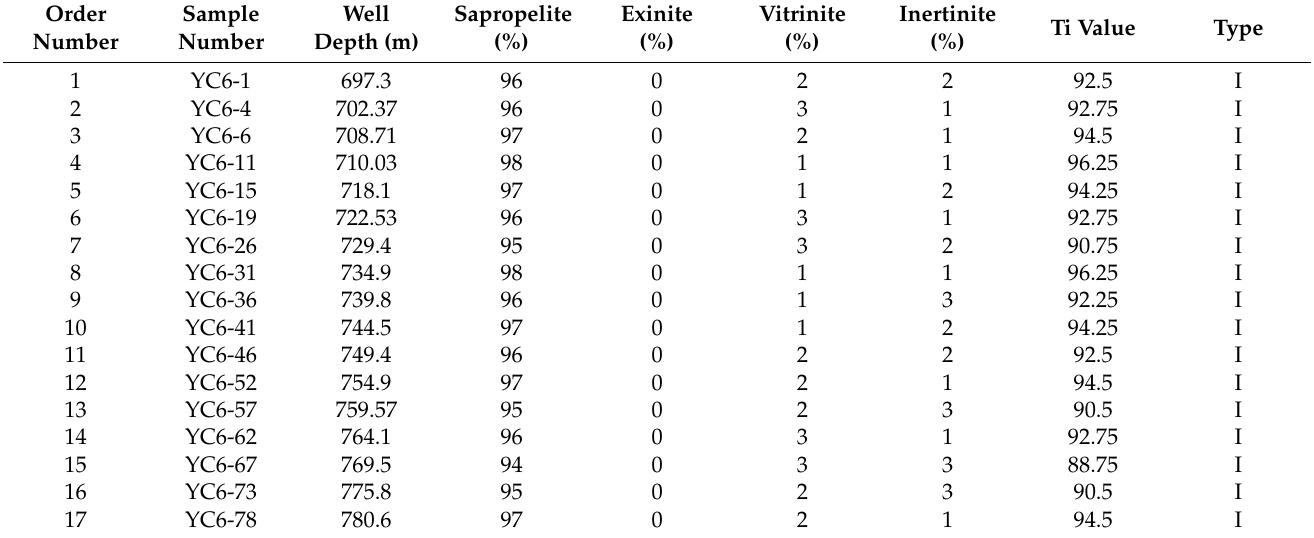
Table 1. Maceral analysis of organic kerogen from Well Yucan-6.